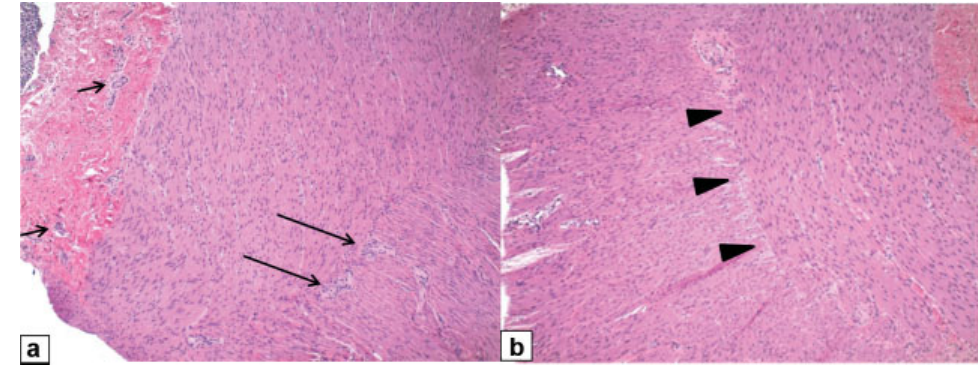
Fig. 2 Histopathology of the doughnut showing ( a ) the presence of ganglion cells in 70% of the circumference on the antimesenteric side ( long arrows indicate the myenteric plexus, short arrows indicate the submucosal plexus) and ( b ) the absence of ganglion cells in 30% of the circumference on the mesenteric side ( arrowheads indicate the aganglionic myenteric plexus).